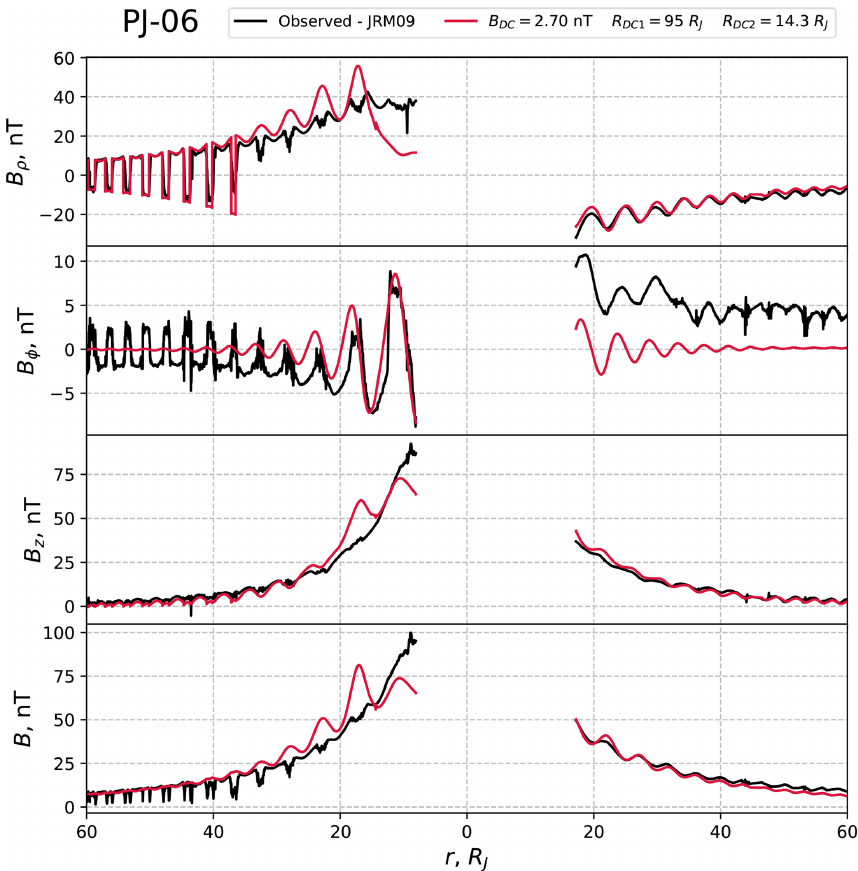
Figure 6. As for Fig. 5, but for perijove